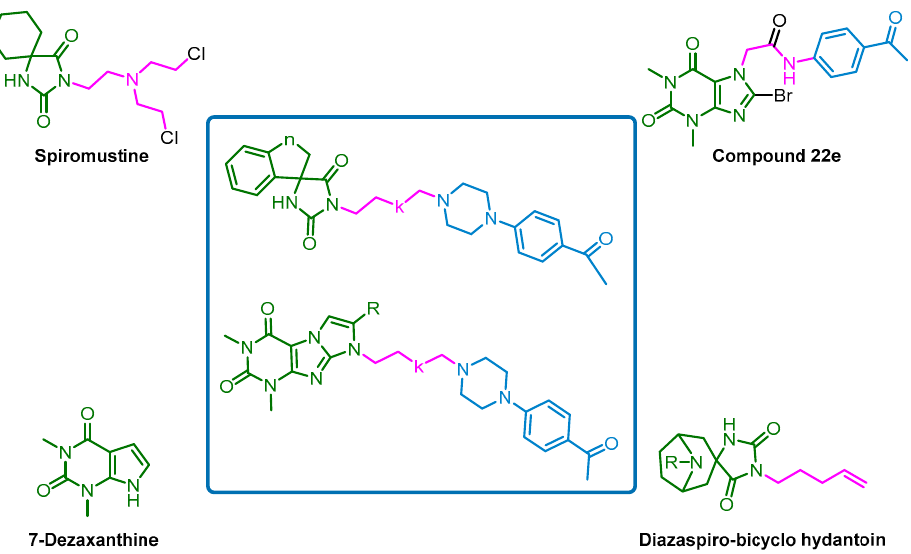
Figure 3. Structures of the designed compounds 1 – 14 based on active anticancer compounds (green—an amide fragment with hydantoin or purine core; blue—an arylamine fragment; magenta—an alkyl linker).